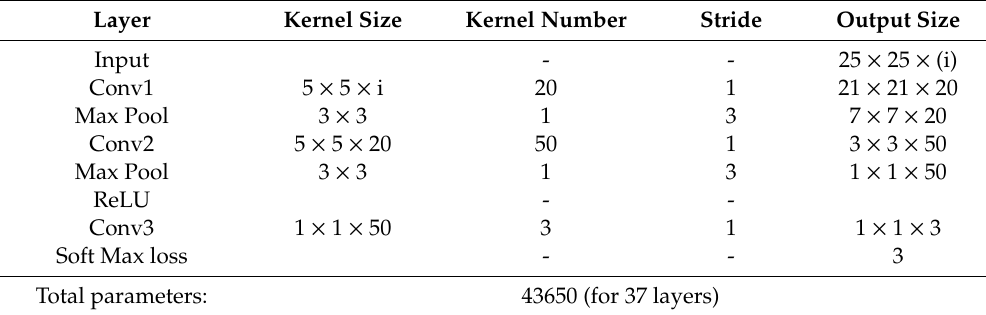
Figure 5. Structure of a 3D-convolutional neural networks (CNN) model for input of (i) layers of size 25 × 25. Table 2. Configuration of a 3D-CNN model for (i) input layers of size 25 × 25.